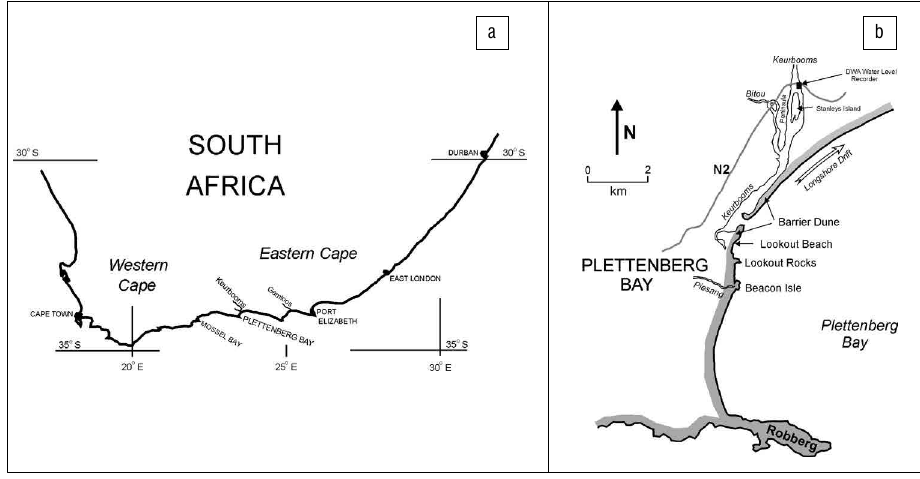
Figure 1: (a) The position of Plettenberg Bay on the south coast of South Africa. (b) Plettenberg Bay, showing the Keurbooms Estuary, Robberg Peninsula and other sites mentioned in the